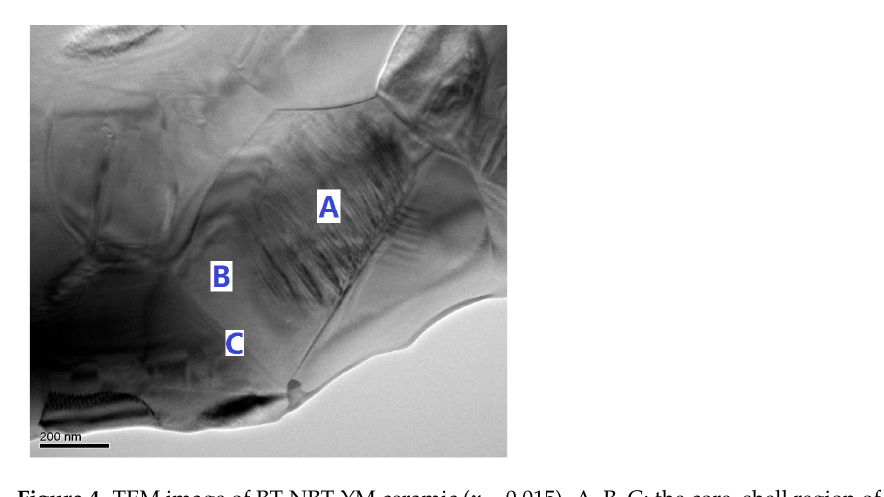
Figure 4. TEM image of BT-NBT-YM ceramic ( x = 0.015). A, B, C: the core, shell region of a grain and grain boundary.